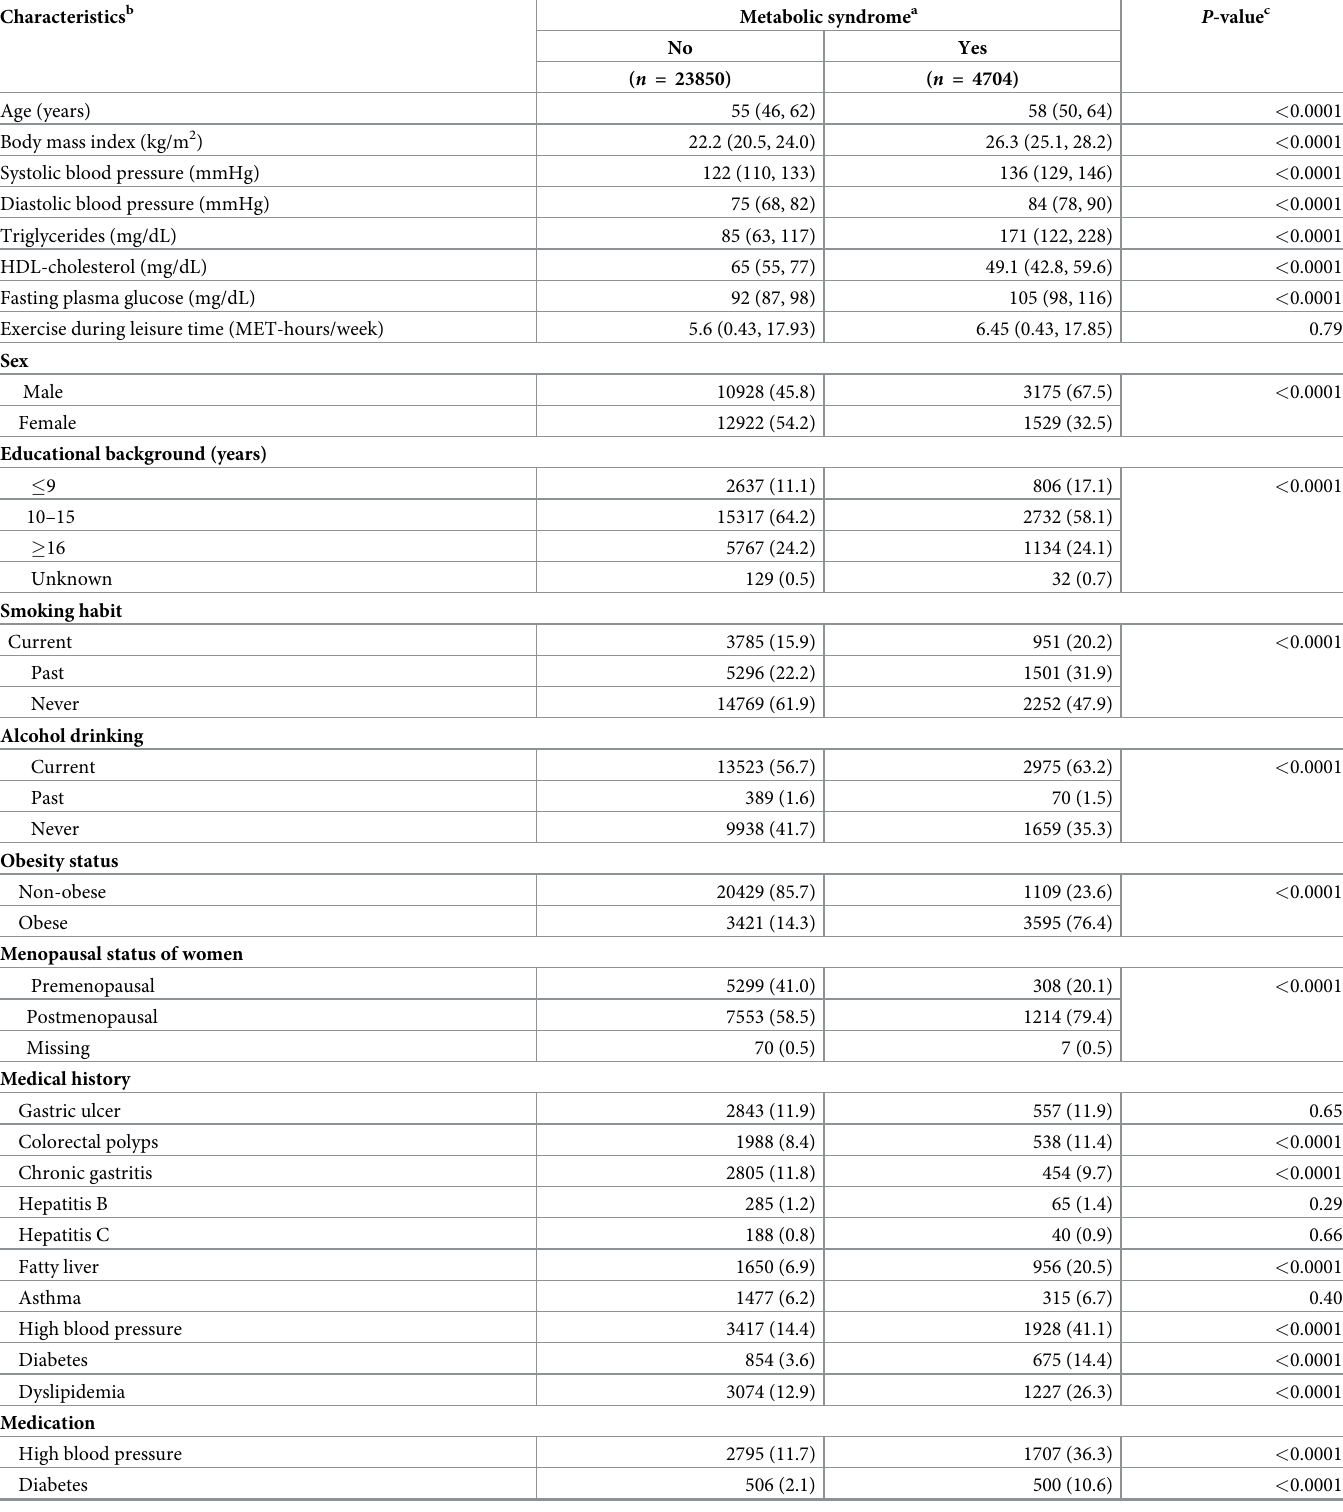
Table 1. Background characteristics of participants according to metabolic syndrome